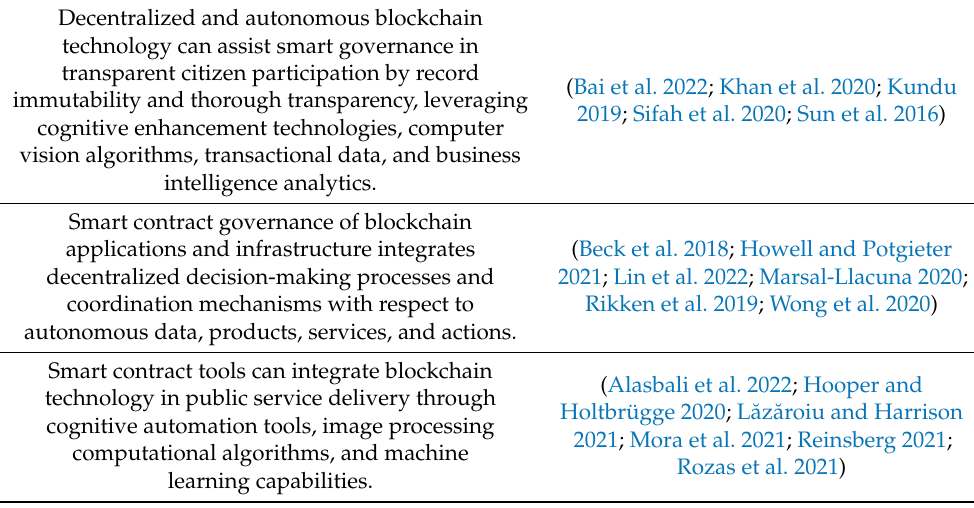
Table 3. Synopsis of evidence as regards focus topics and descriptive outcomes. Decentralized and autonomous blockchain technology can assist smart governance in transparent citizen participation by record immutability and thorough transparency, leveraging cognitive enhancement technologies,